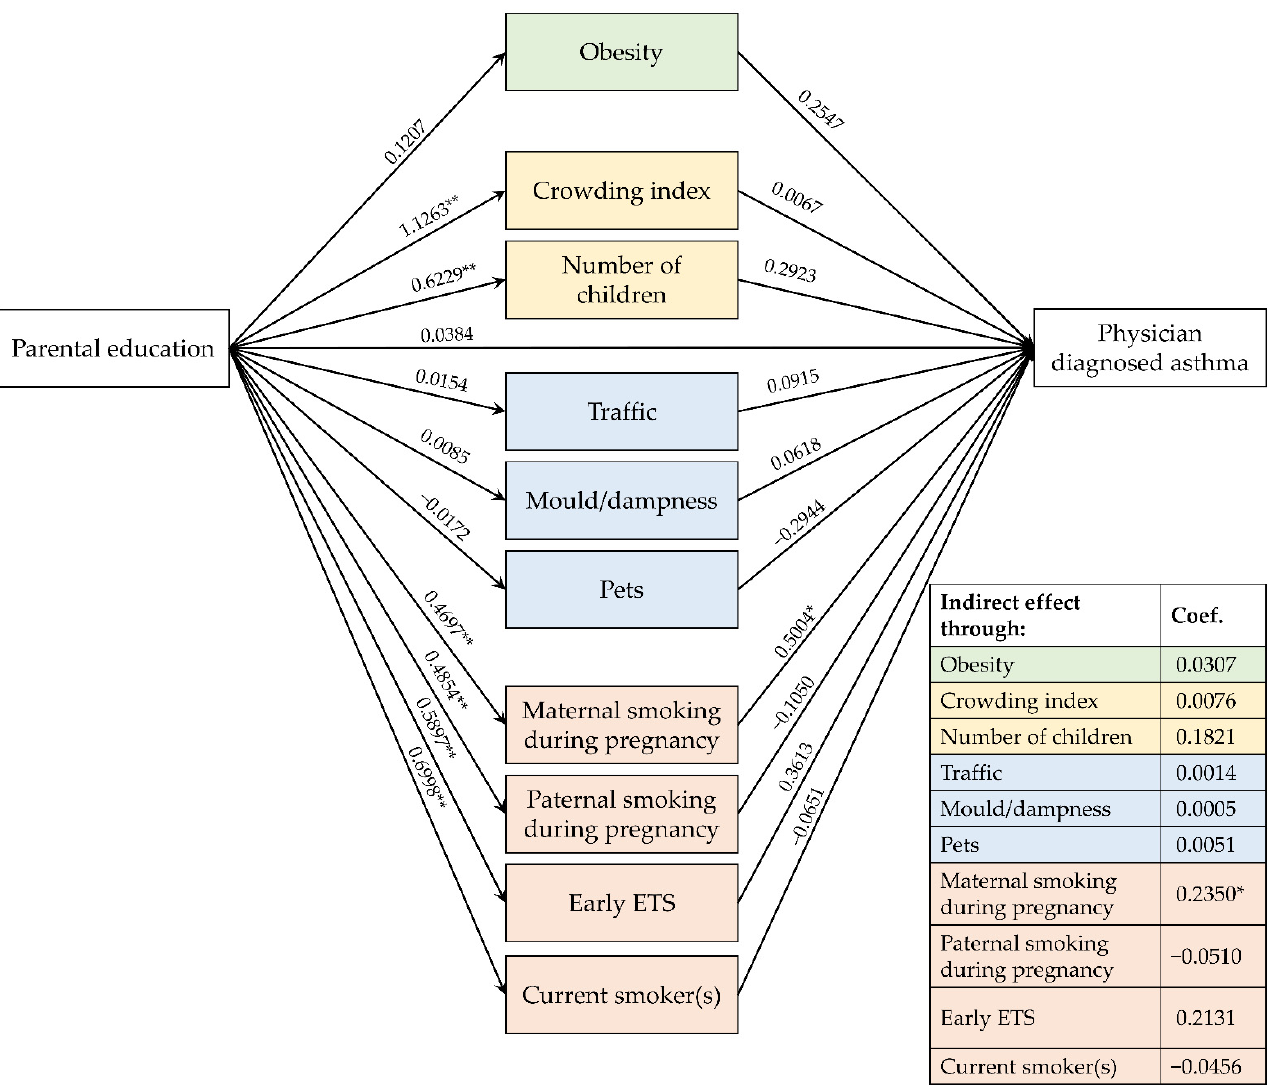
Figure 3. Path diagram of the relationships between parental education, risk factors and physician- diagnosed asthma. Note. ETS: Environmental tobacco smoke; * p < 0.05; ** p < 0.01.